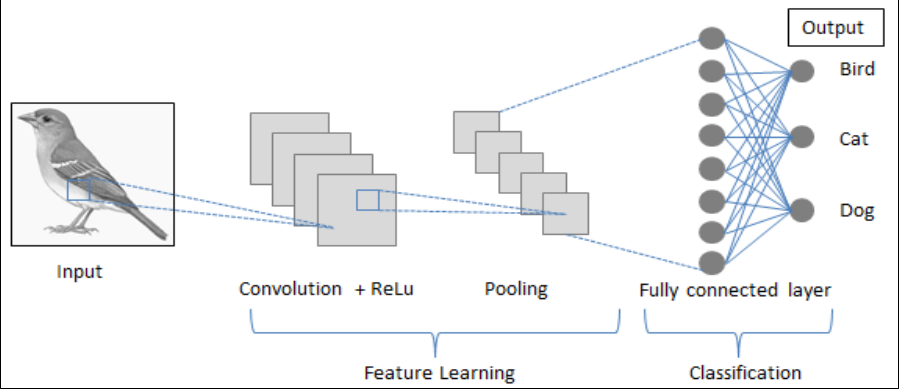
Figure 6. Basic architecture of CNN.